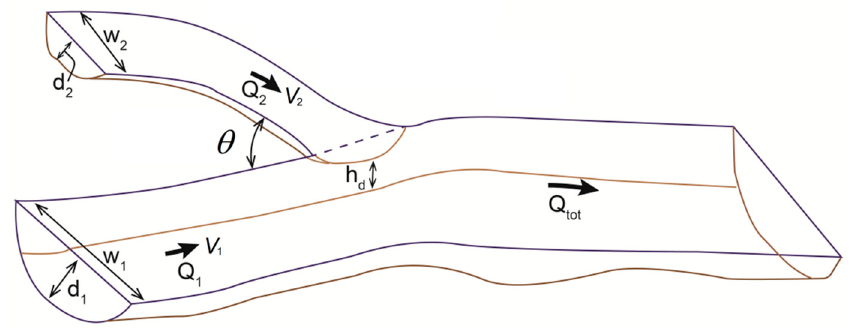
Figure 2. Definition of confluence geometry.